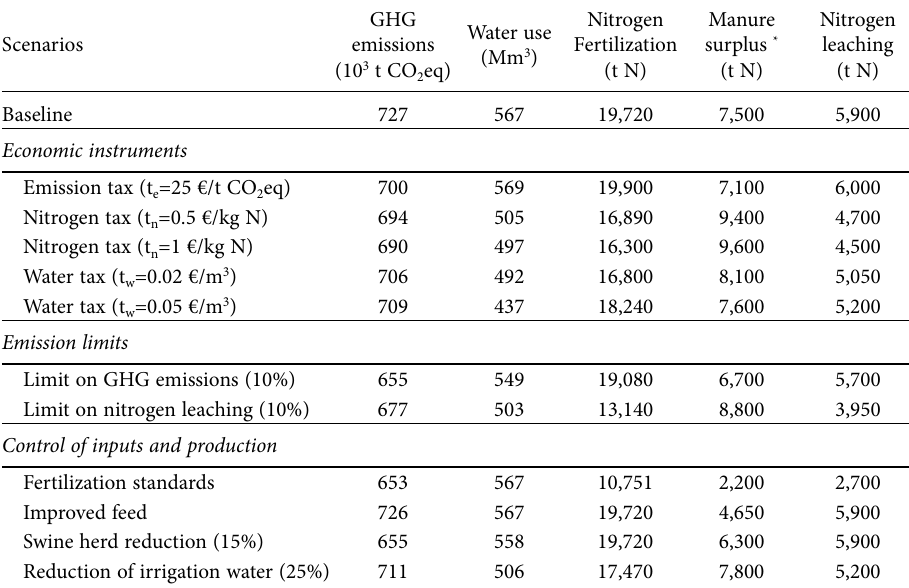
Table 4. GHG emissions, inputs use and pollution loads under each